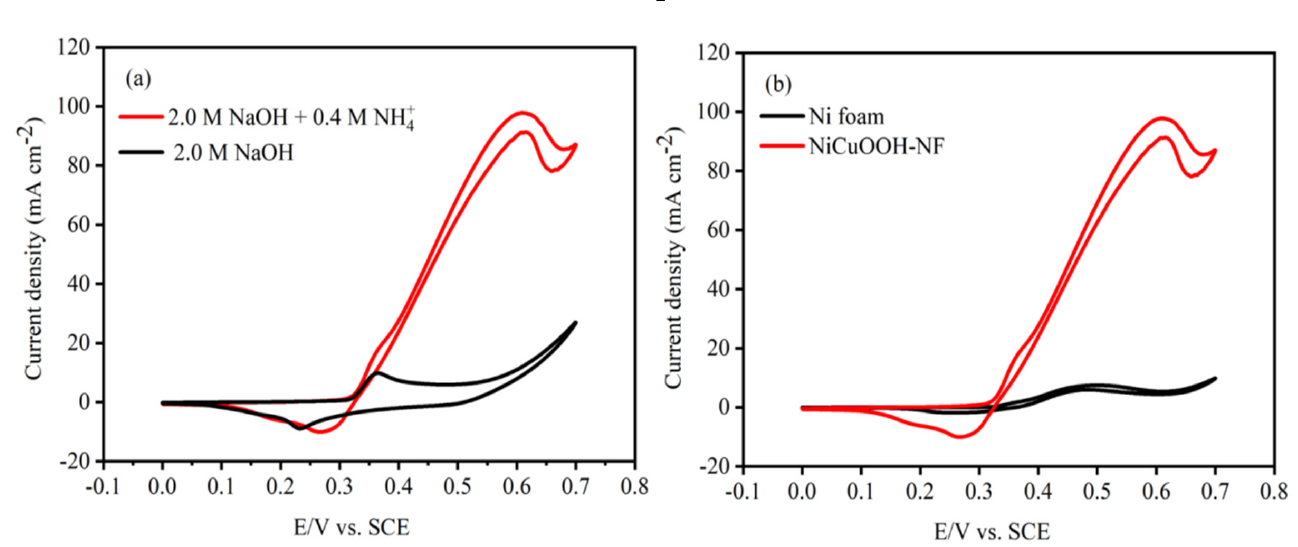
Figure 3. ( a ) the comparison of CV curves with or without the addition of 0.4 M NH 4+ in 2.0 M NaOH for the NiCuOOH-NF electrode; ( b ) the comparison of CV curves between NiCuOOH-NF electrode and Ni foam electrode at 2 M NaOH + 0.4 M NH 4+ with a scan rate of 20 mV s − 1 . Additionally, AOR does not seem to refer to the reduction of NiCu(III) to NiCu(II) because the reverse peak does not decrease on all obtained electrodes. Thus, the direct electron transfer from ammonia to the electrode can be